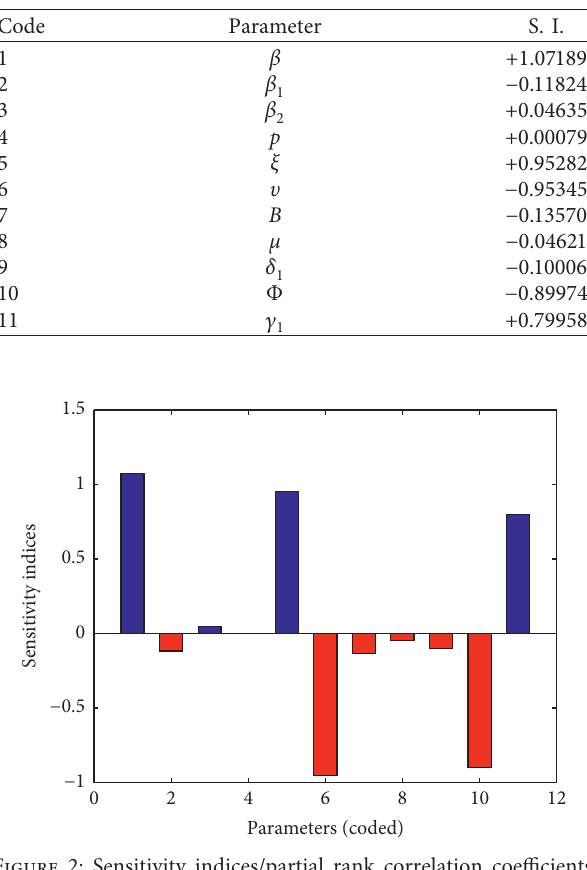
Table 3: Sensitivity index (S. I) of R